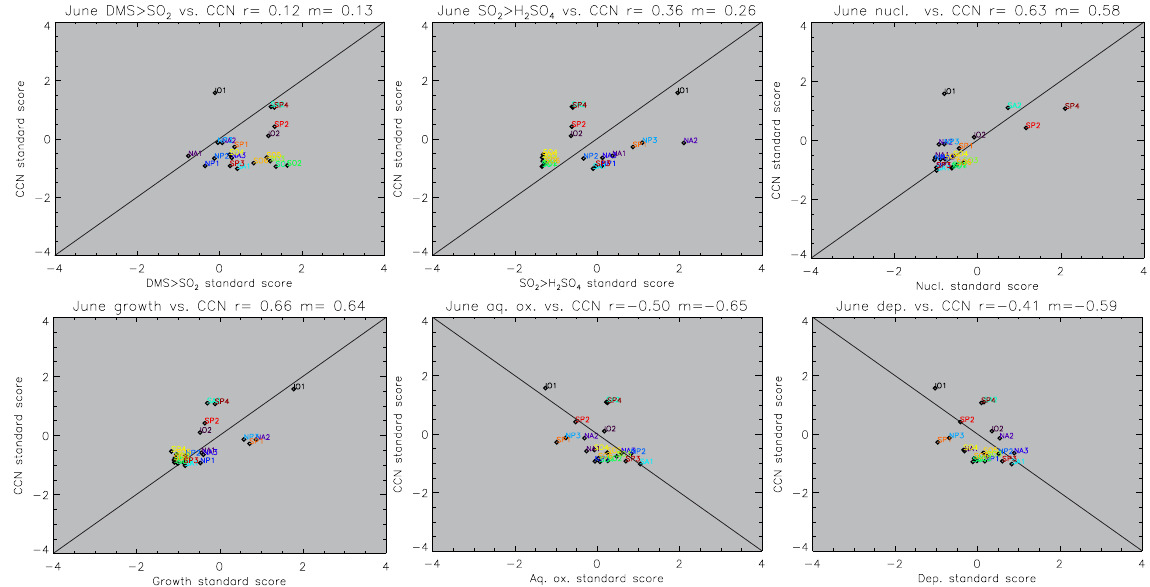
Fig. 8. June standard scores for CCN sensitivities plotted against the process sensitivities for each patch. Also shown are the 1:1 line (or negative 1:1 line), r and m values of the linear best fit. The patch names are shown next to their respective datapoints. Colours are used to help differentiate the datapoints from one